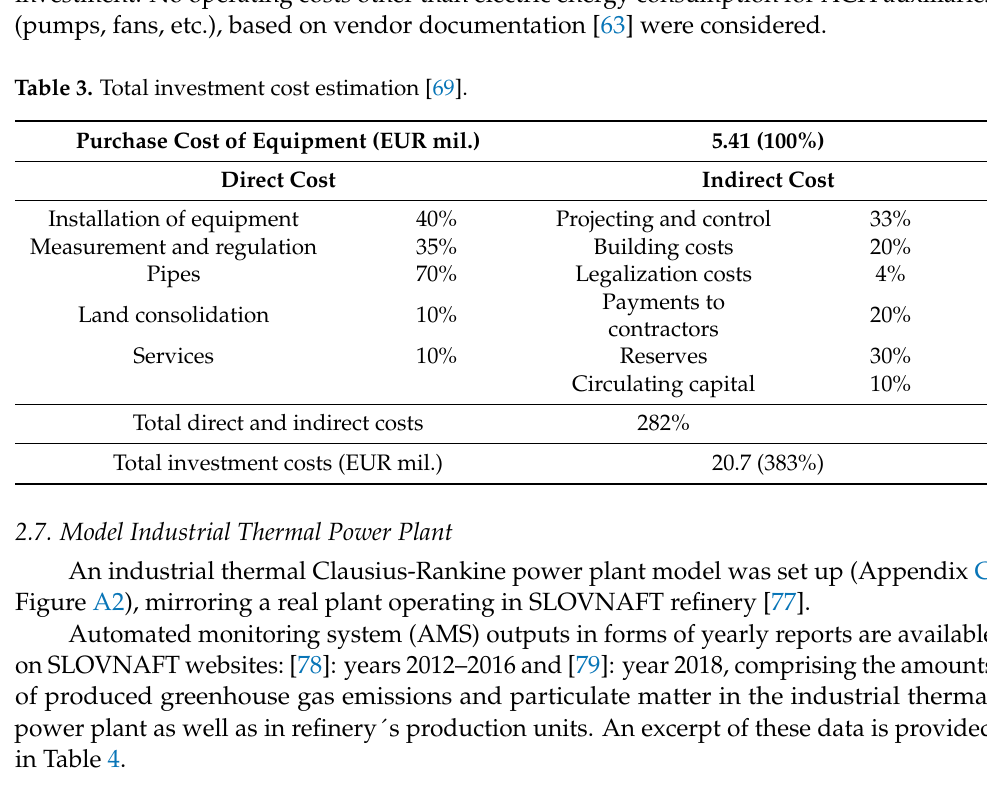
Table 4. Selected data on greenhouse gas emissions from thermal power plant based on [78,79]. Year (Days of Validated AMS Operation and Data Recording) Emissions (t)